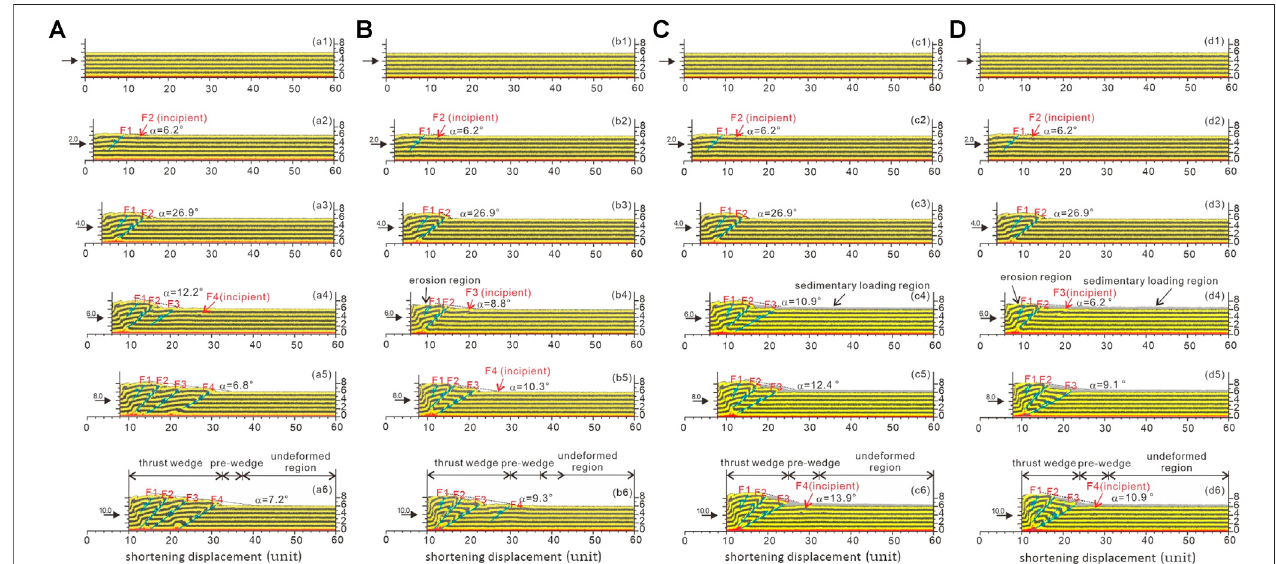
FIGURE 6 | The structural evolution of four models with total shortening of 10 units. (A) Model 1 with no synkinematic erosion or sedimentation, (B) Model 2 with synkinematic erosion and no sedimentation, (C) Model 3 with synkinematic sedimentation and no erosion, and (D) Model 4 with synkinematic erosion and sedimentation (d).